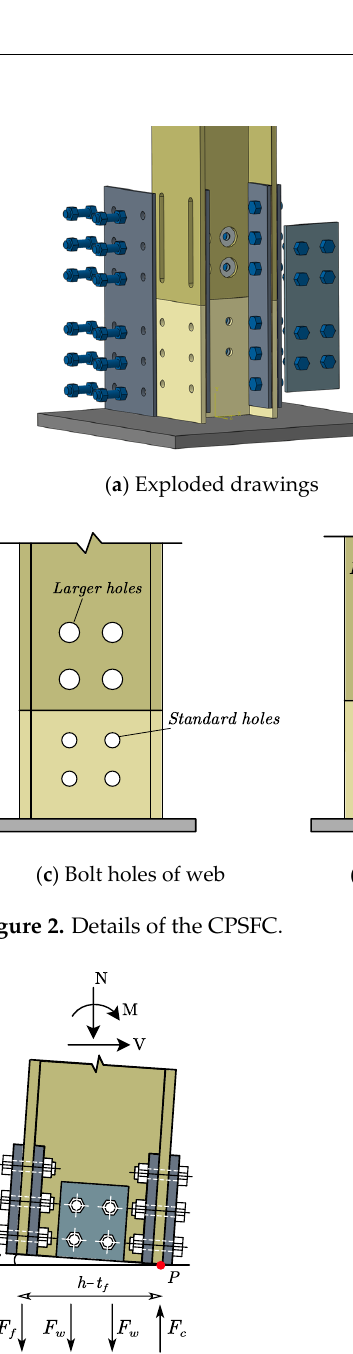
Figure 3. Force diagram of the CPSFC.